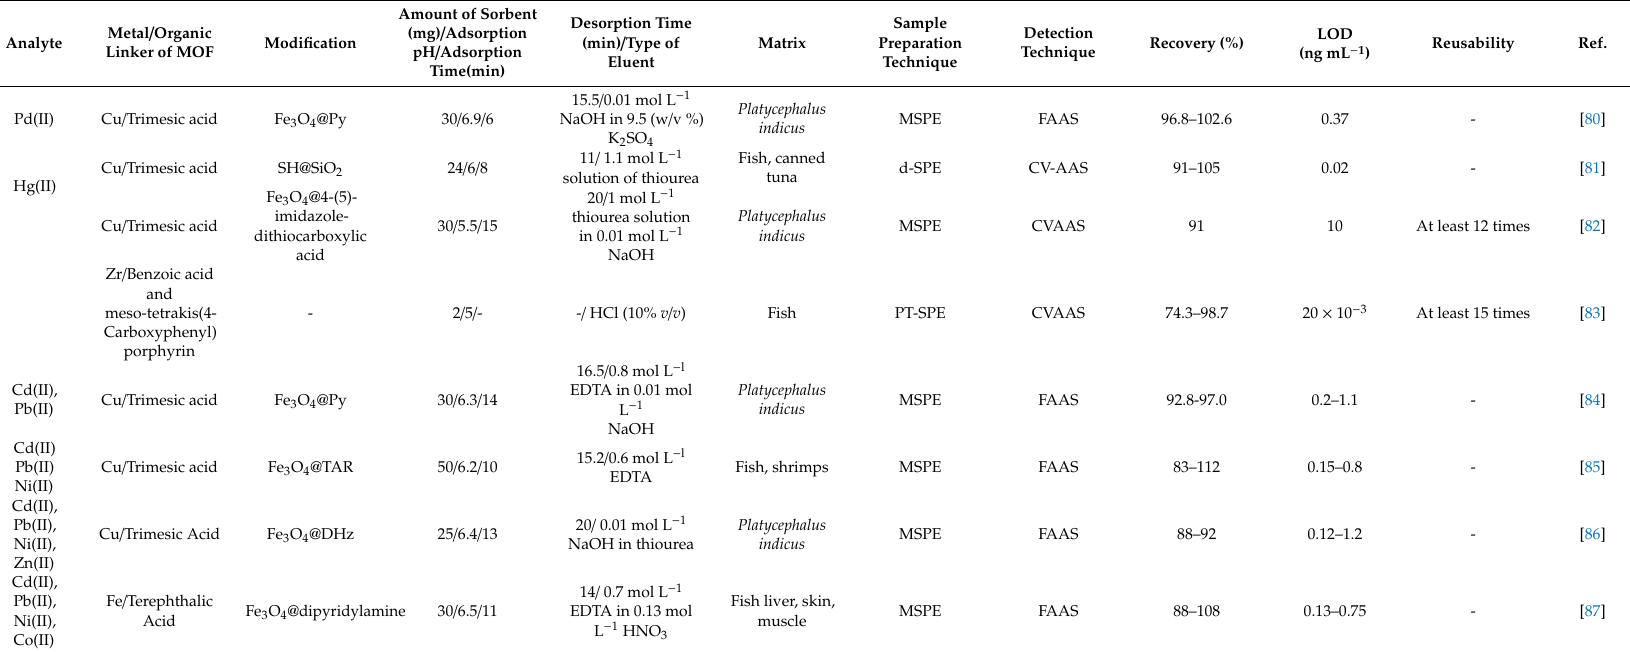
Table 2. Application of MOFs for the extraction of metal ions from fish